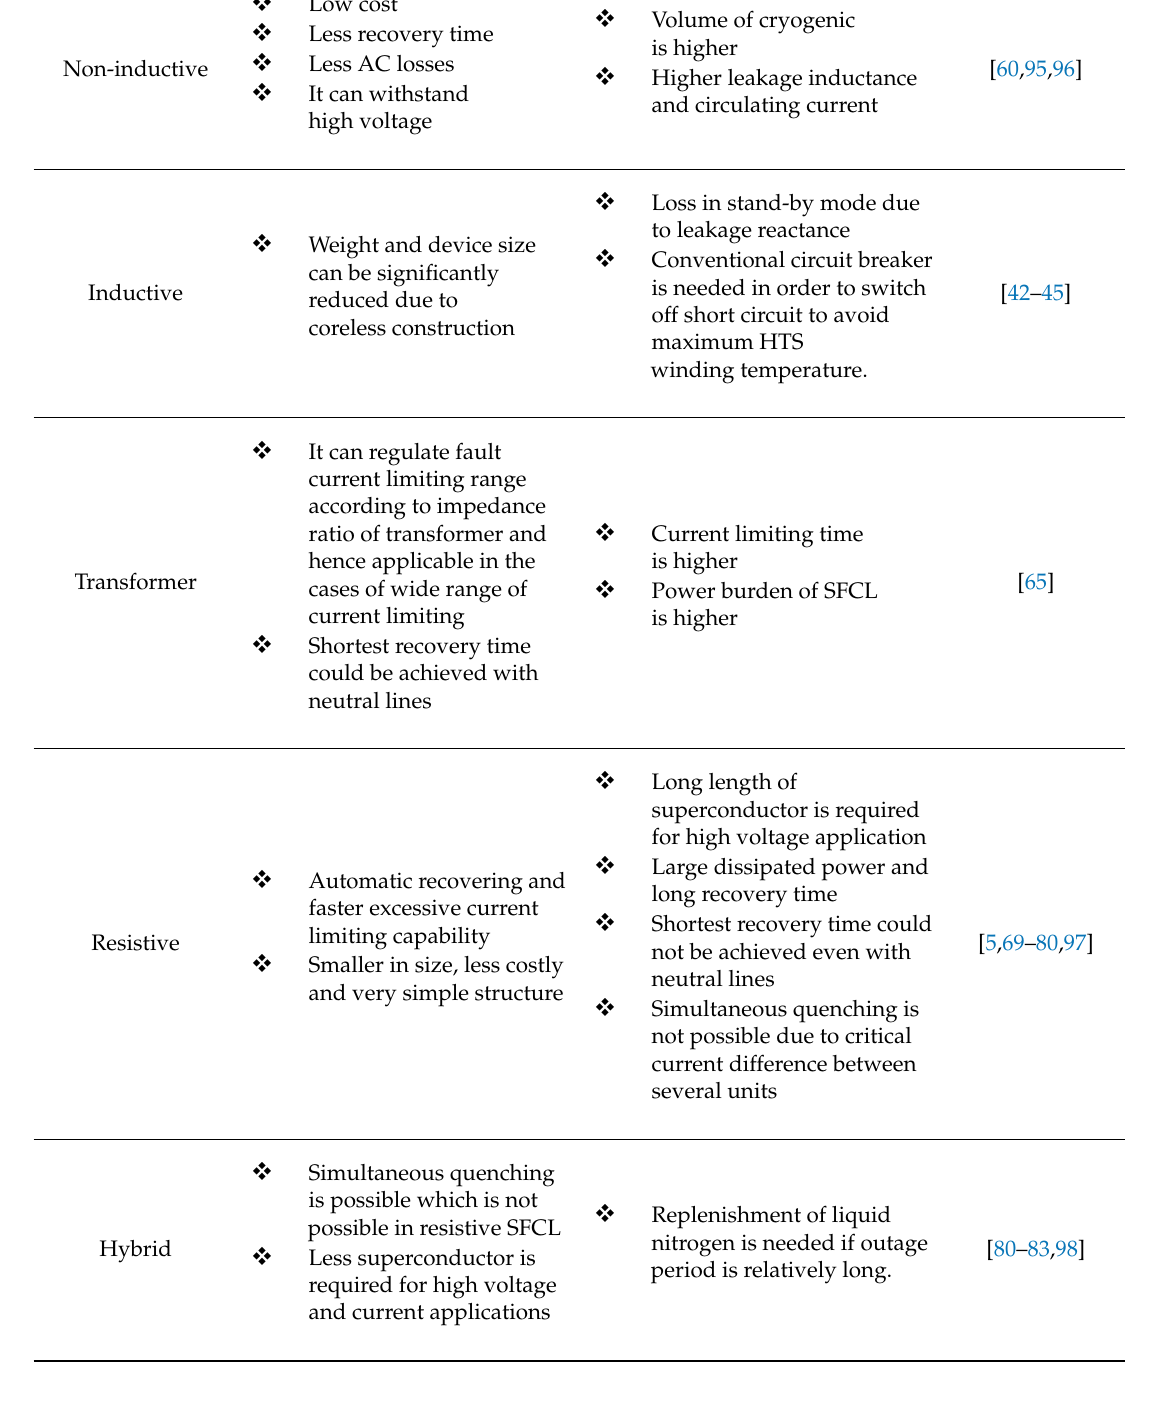
Figure 4. The phases for implementing a N-AHP in SWOT analysis.